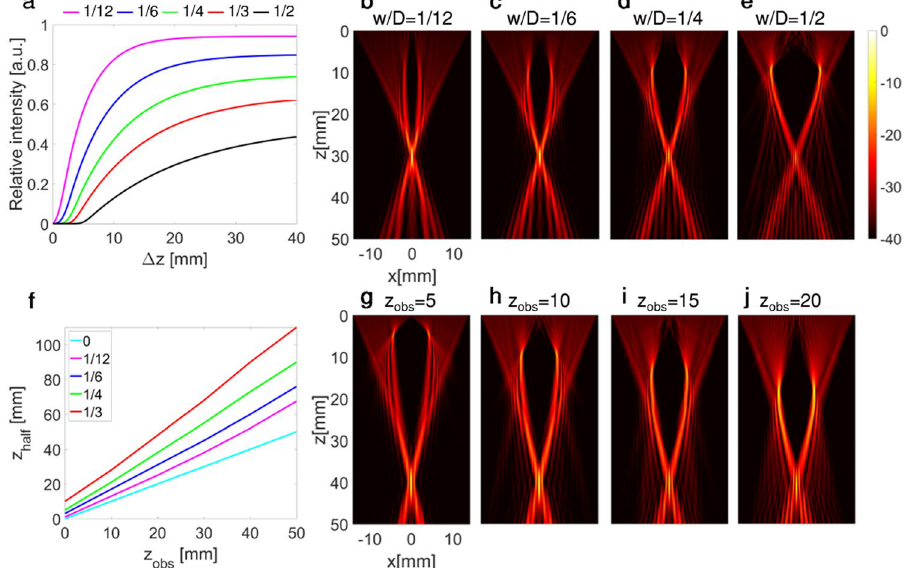
Figure 5. Simulated effect of the obstacle width and depth for D = 28.2 mm. ( a ) The focal point intensity as a function of the distance of the target from the obstacle for varied w/D, normalized by the intensity obtained with two-way focusing without the obstacle. ( b – e ) Emitted field for z obs = 10 mm, z target = 30 mm, and w/D = 1/12, 1/6, 1/4, 1/2 in b-e, respectively. ( f ) Depth at which the axial center line intensity reaches 1/2 of its maximal value (z half ) as a function of the obstacle depth, for varied w/D. ( g – j ) Emitted field for z obs of 5, 10, 15, 20 mm for ( g – j) , respectively. Axes and 40 dB dynamic range colorbar are common to ( b – e ), and ( g – j ). For figures ( g – j ), w/D = 1/3 and z target = 40 mm.